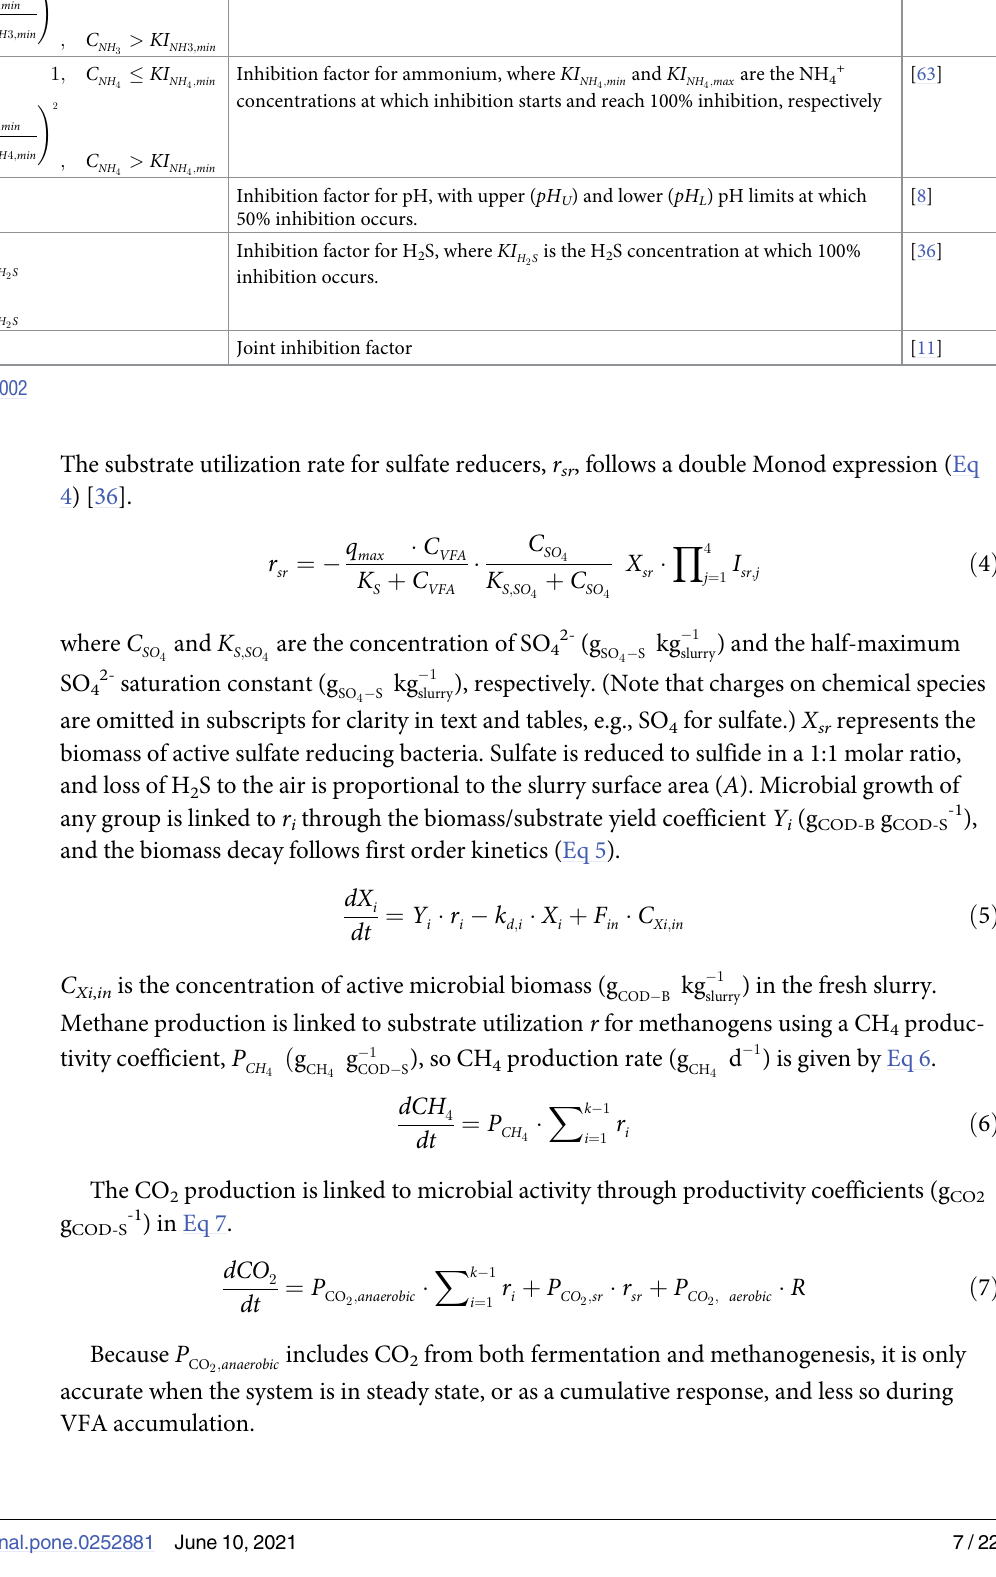
Because P includes CO from both fermentation and methanogenesis, it is only 2 CO 2 ; anaerobic accurate when the system is in steady state, or as a cumulative response, and less so during VFA accumulation.